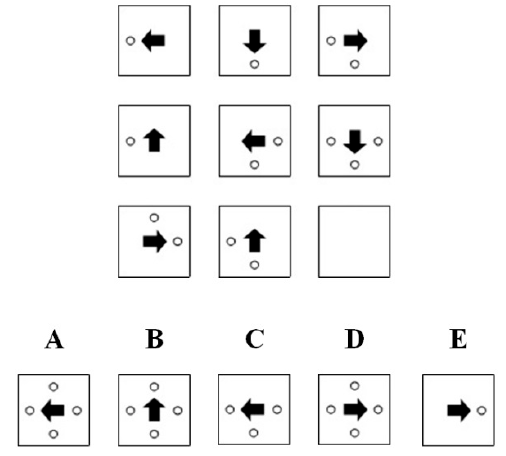
Figure 1. Classic figural matrix item.